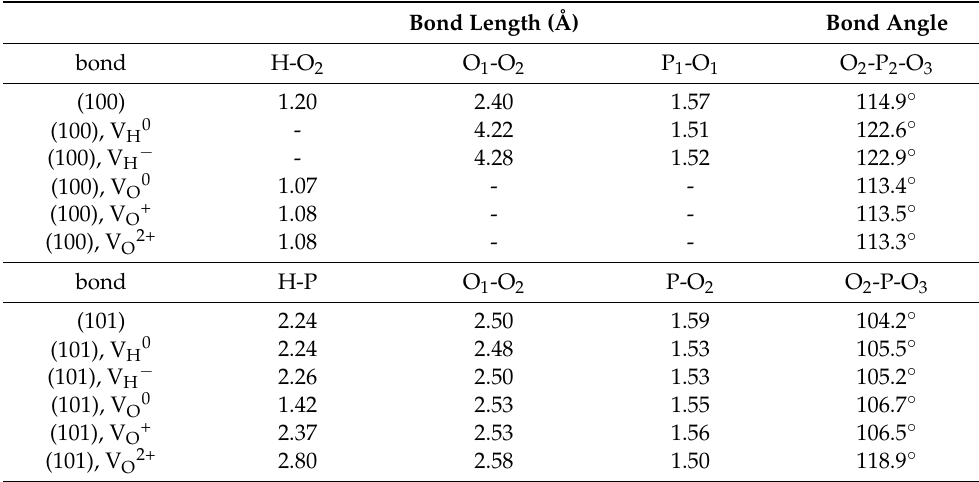
Table 2. Bond lengths and bond angles between atoms adjacent to the vacancy defects on the KDP crystals’